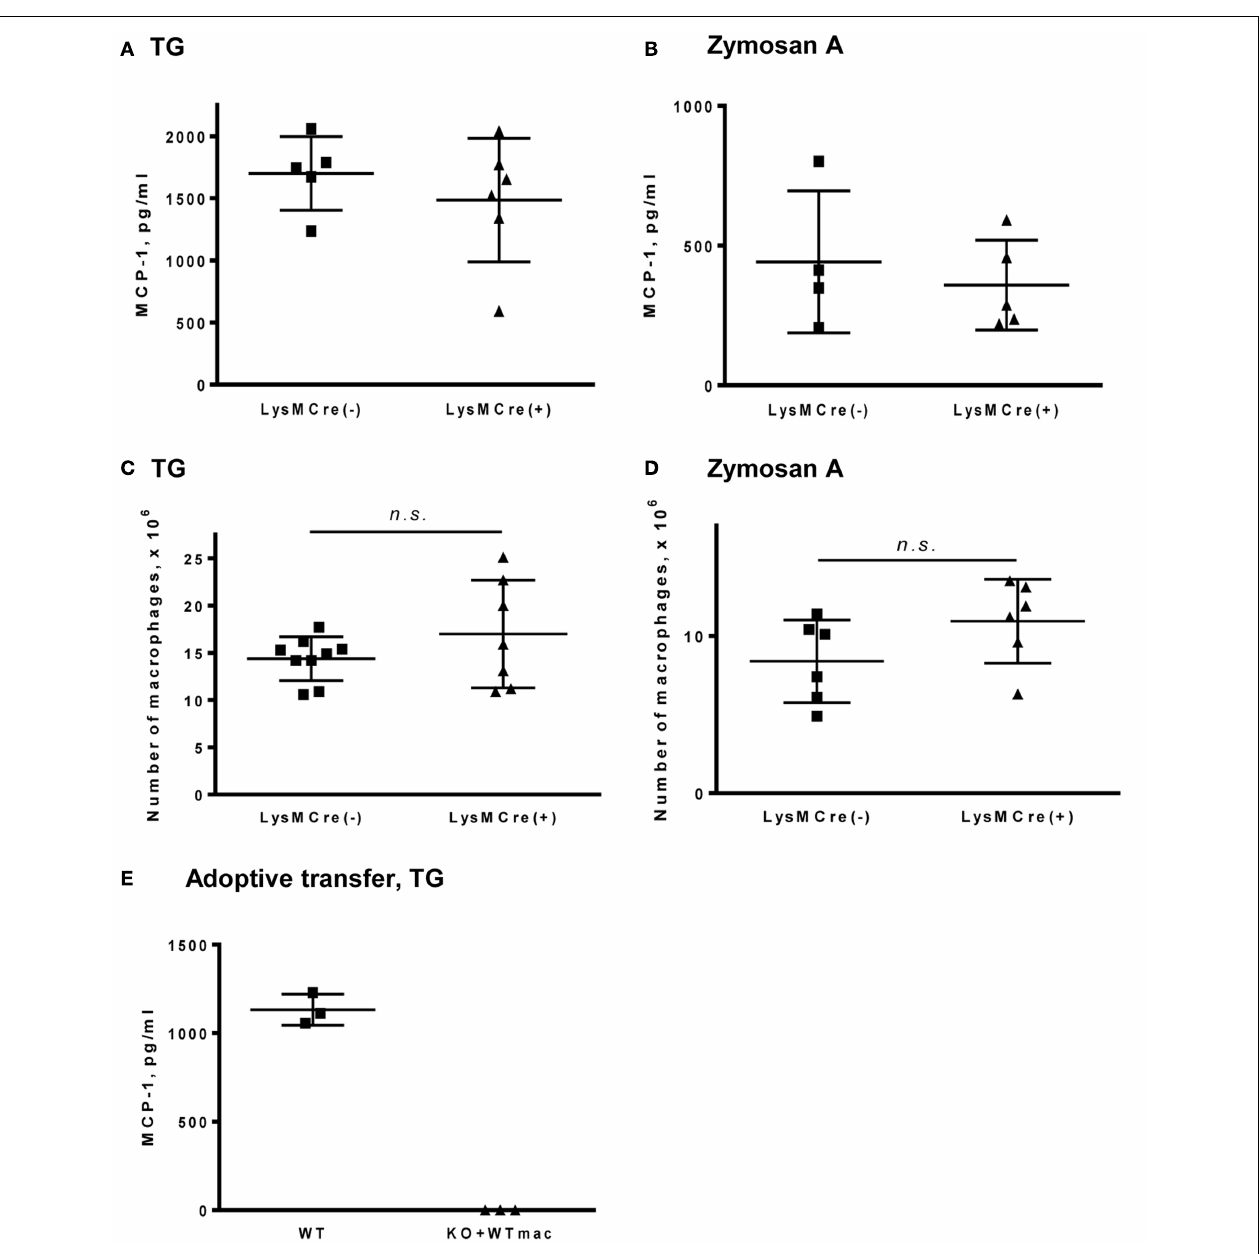
with 5ml PBS 4days after injection and the number of macrophages was counted. Data is presented as the mean ± SD. (E) Peritoneal resident cells were collected fromWT C57BL/6 mice and transferred into the peritoneal cavity of MCP-1 KO mice.WT and MCP-1 KO mice adoptive transferred with WT peritoneal cells were i.p. injected with 1ml of 3%TG. Peritoneal cavities were flushed with 5ml PBS 4h after injection and the concentration of MCP-1 in the peritoneal fluids was measured by ELISA. Data is presented as the mean ± SD obtained from three